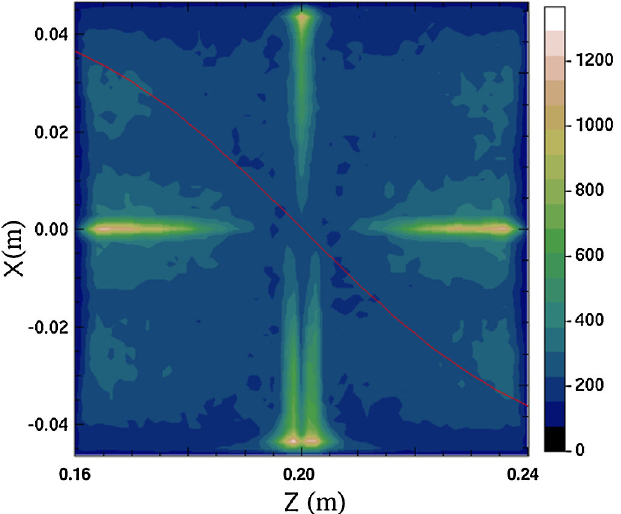
FIG. 6. Color contour plot of electron density in the x - z plane (density is integrated over y ) for a simulation near the field null, which is at z ¼ 0 : 2 m . Snapshot at 616 ns, i.e., just before the 45th beam bunch. Color scale is linear (see scale to right) but units are arbitrary. Curve overlaying the plot is proportional to B y .